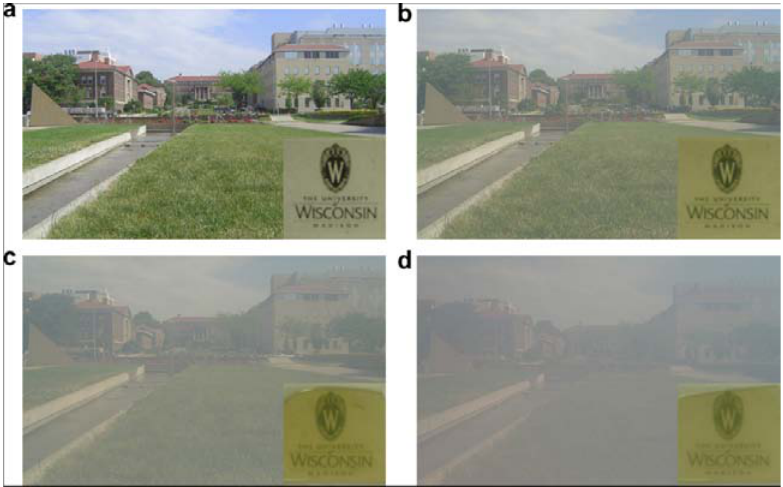
Figure 10. Transparencies of the (a) PC neat resin, (b) 1 wt % and (c) 2 wt % PC/alumina (SMA-coated), and (d) 2 wt % PC/alumina (untreated) (adapted from